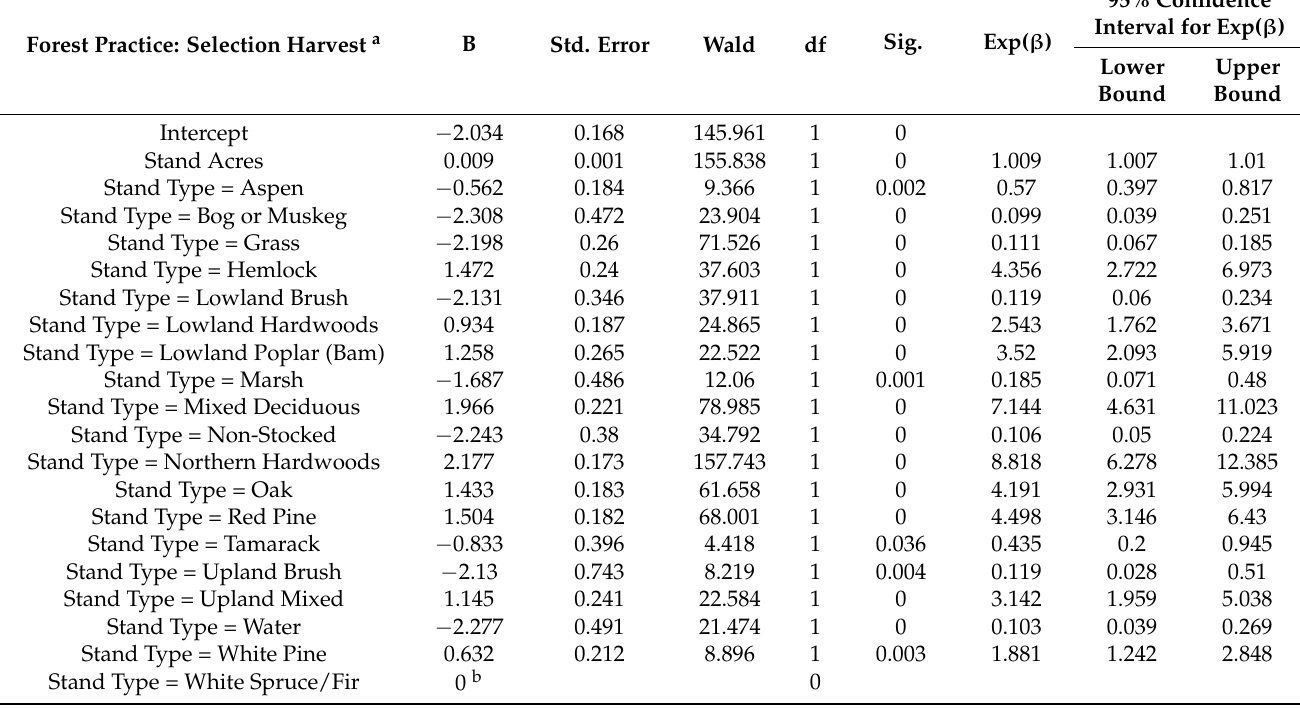
Table 7. Multinomial logistic regression parameter estimates for significant results. Stand acres and stand type as indepen- dent variables (showing results from selection harvest). N = 20,915 unique forest stands that are enrolled in the Qualified Forest